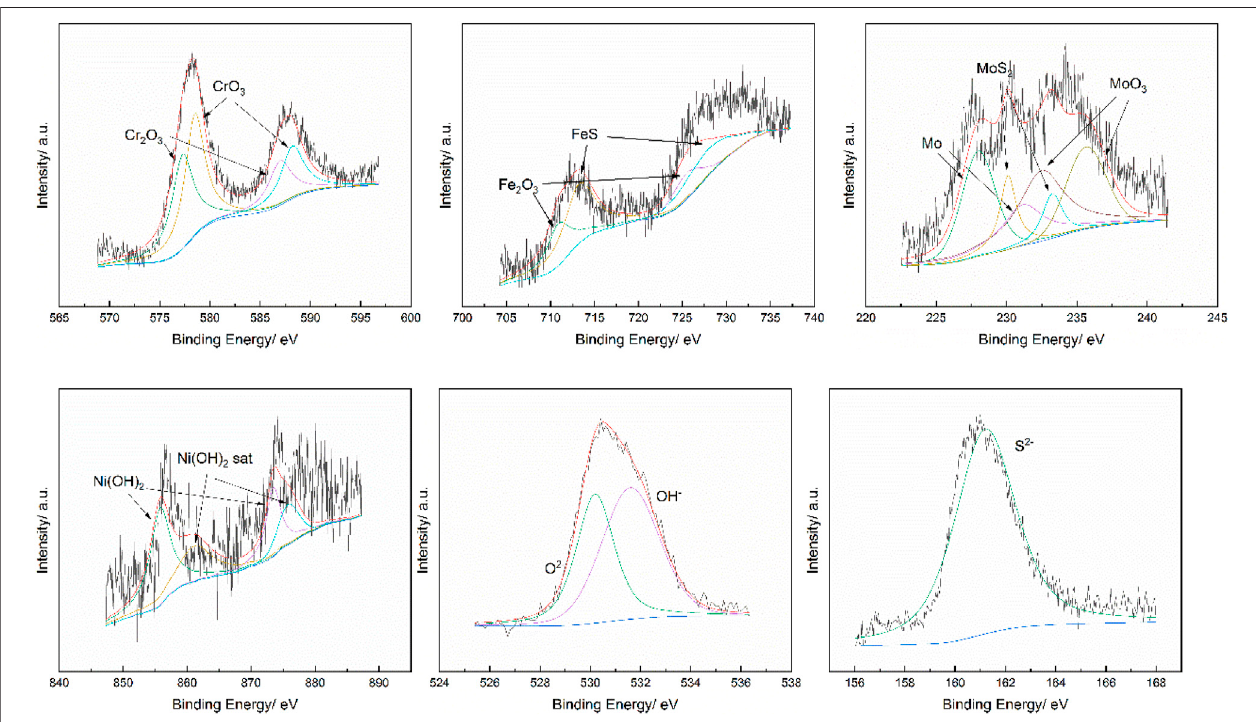
FIGURE 5 | XPS analysis results for Alloy 825 at 150 ° C, 1.2 MPa H 2 S 3.2 MPa CO 2 .